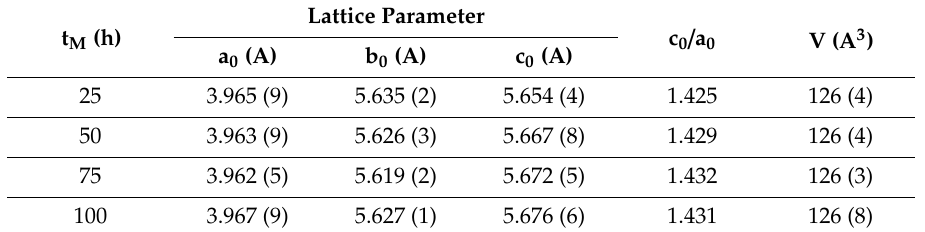
Table 1. Lattice parameters calculated for KNN ceramics obtained from t M activated powders